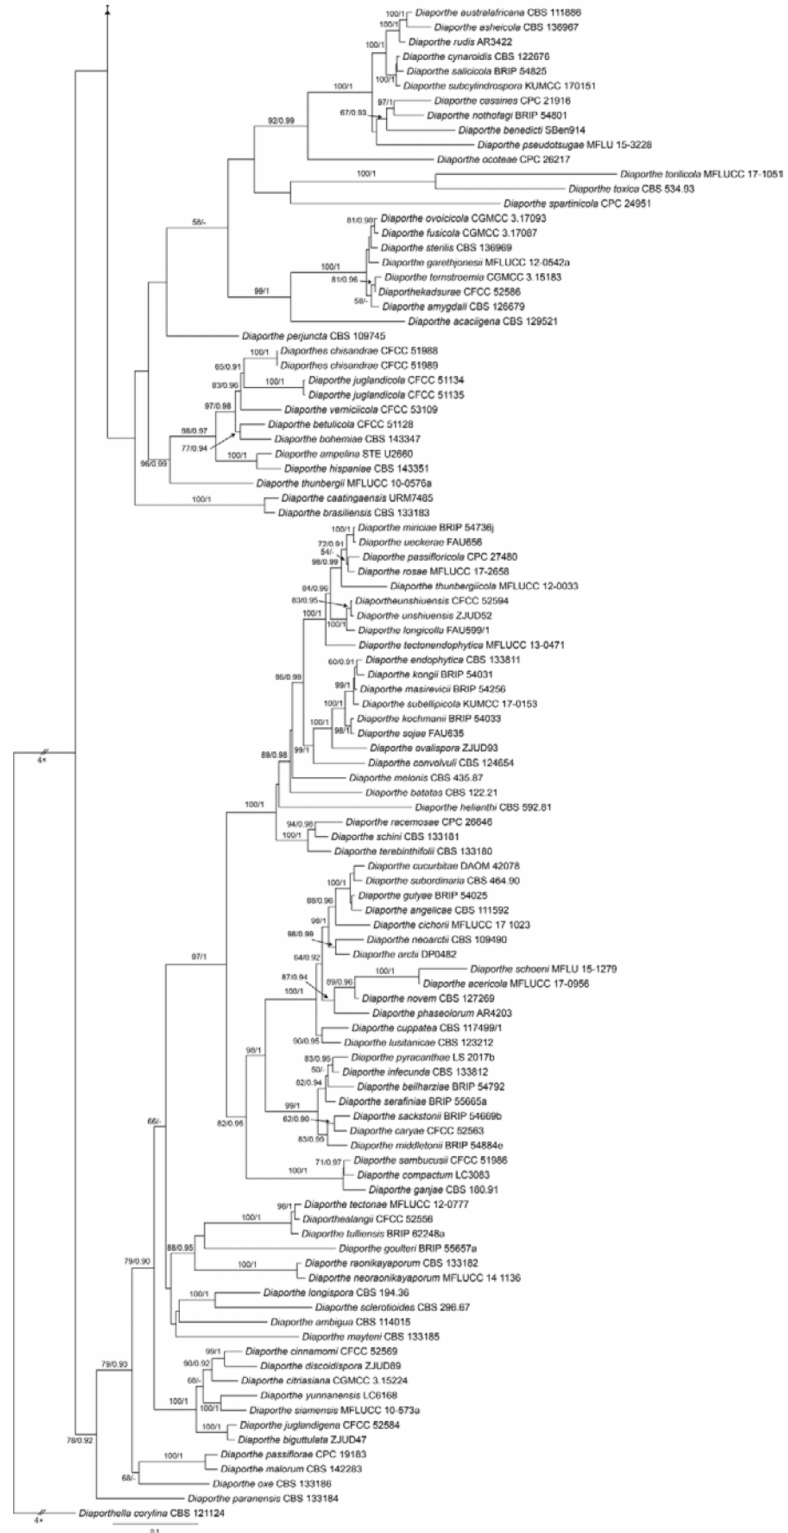
Figure A9. Phylogram generated from RAxML analysis based on combined ITS, cal , his , tef1 and tub2 sequence data of Diaporthe isolates. The tree was rooted to Diaporthella corylina (CBS 121124). The scale bar indicates 0.1 nucleotide changes per site. Isolates from this study are marked in blue, and the identified species is marked in